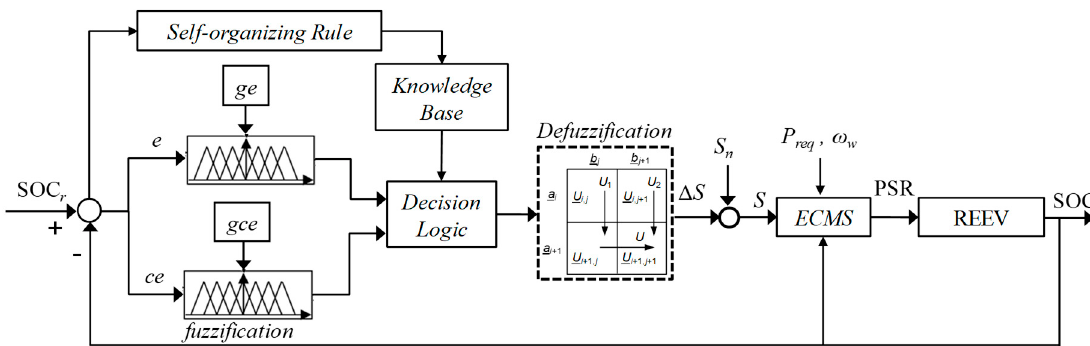
Figure 13. Proposed adaptive power management strategy.